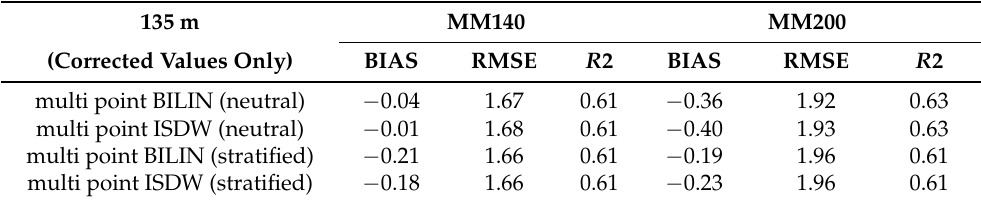
Figure 11. Wind roses after correction and downscaling based on multiple meso-scale grid points(four) for the two met mast locations on hill top (MM200-( a )) and southwest of the hill (MM140-( b )). Table 2. Statistical analysis of multi-point down-scaling methods at two metmast positions on site Rödeser